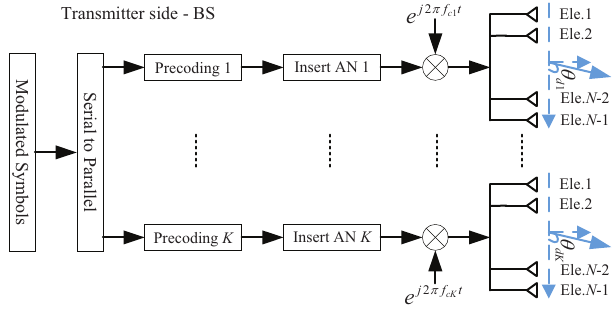
Figure 5. The architecture of the BS for the proposed DM based on a multi-carrier multiple antenna arrays